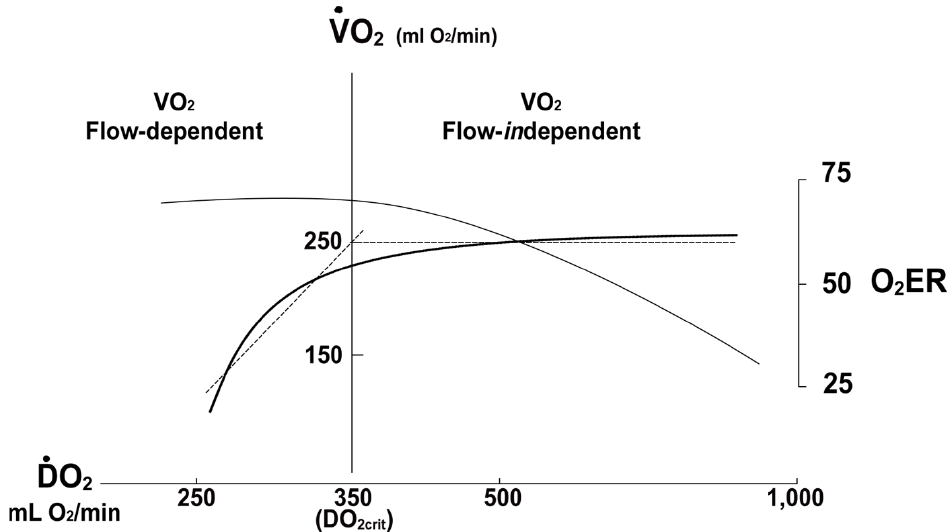
Figure 2. DO 2 CRIT defines shock. As DO 2 (solid black line) decreases secondary to a fall in cardiac output, drop in Hgb concentration, or both, O 2 ER (solid grey line) increases to maintain VO 2 constant until extraction is maximized. At this point, designated as DO 2 CRIT (also referred to as the anaerobic threshold), VO 2 begins to decrease with further decreases in DO 2 . When DO 2 > DO 2 CRIT t, VO 2 is flow-independent; when DO 2 < DO 2 CRIT , VO 2 becomes flow-dependent. In addition, DO 2 CRIT is associated with the onset of lactate formation and accumulation. Thus, shock can be defined conceptually as the presence of DO 2 less than DO 2 CRIT , producing a reduction in VO 2 . Normal DO 2 = 800 mL O 2 /min/m 2 ; normal VO 2 = 200 mL O 2 /min/m 2 ; normal O 2 ER = 25%.